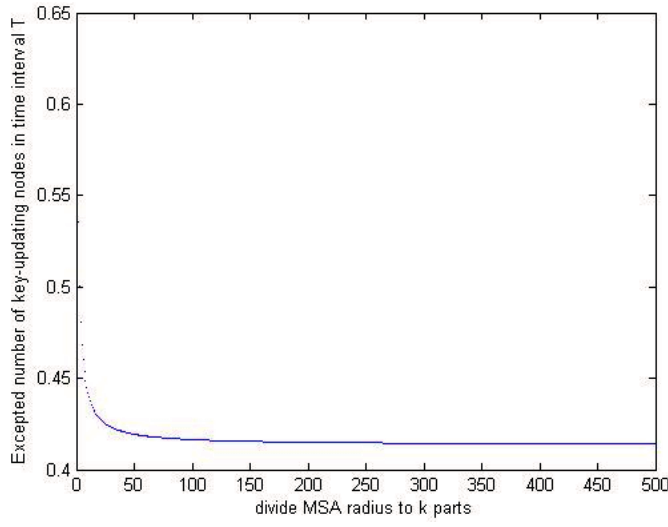
Figure 9. The upper limit of the expected numbers of key-updating